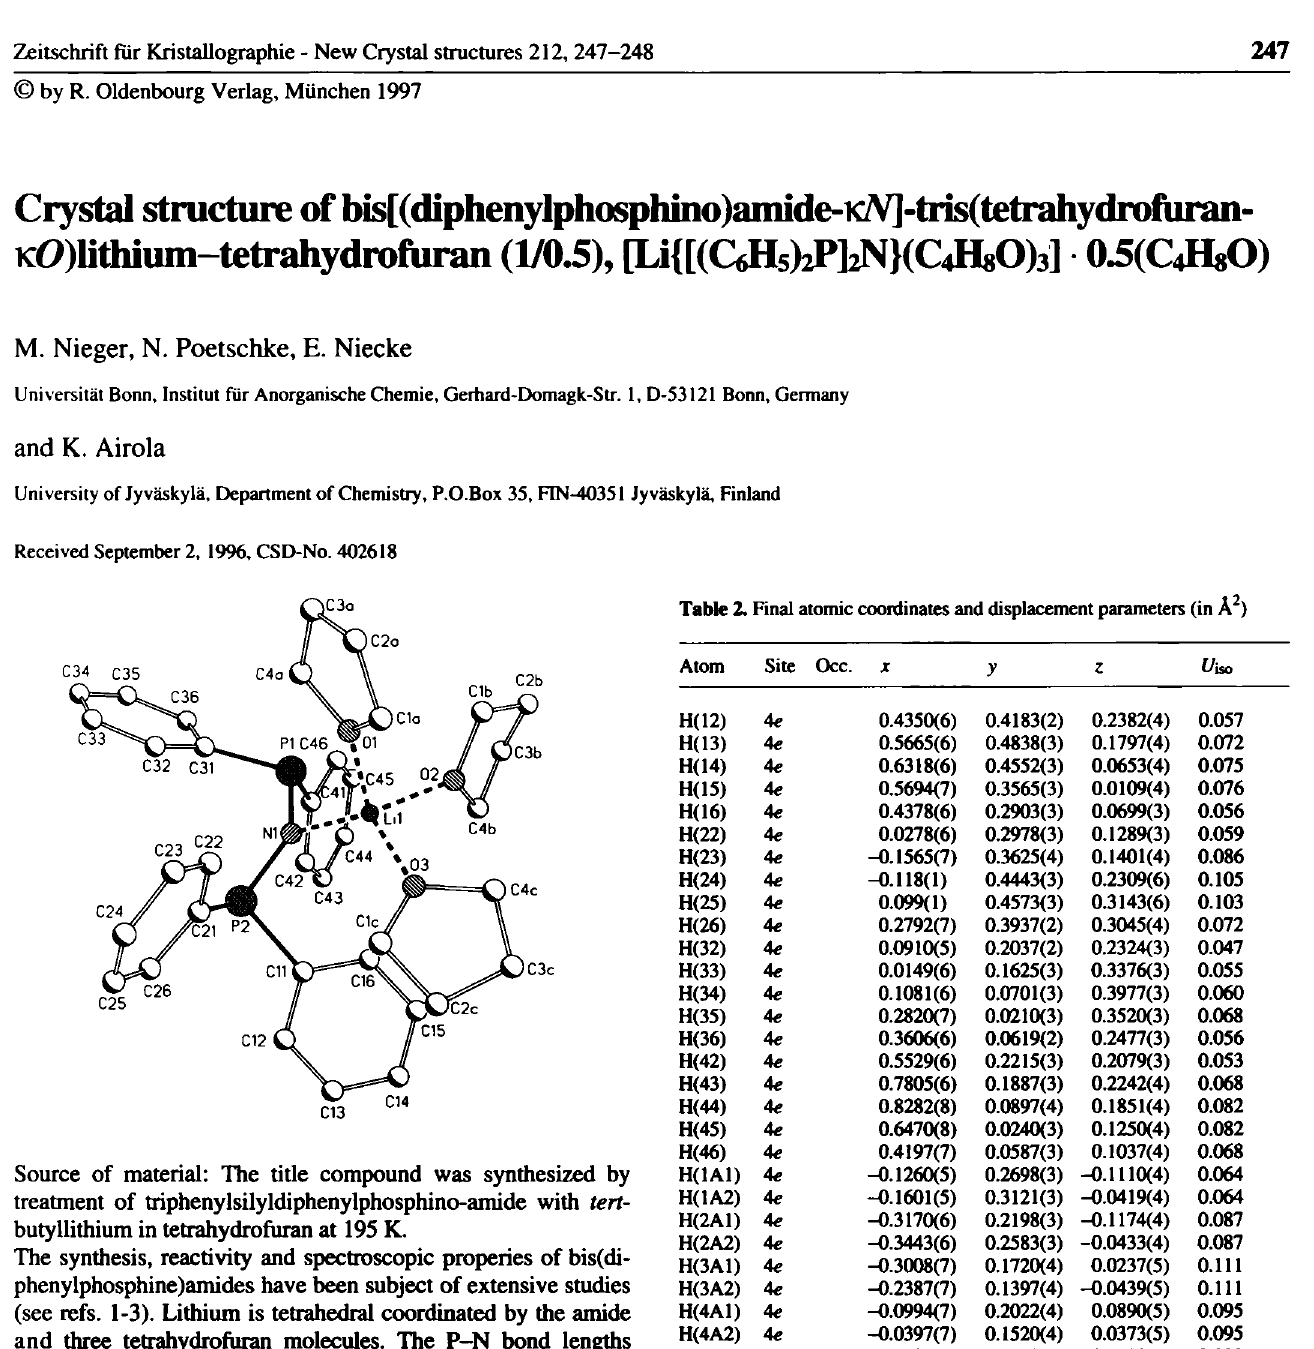
Table 1. Parameters used for the X-ray data collection Crystal: